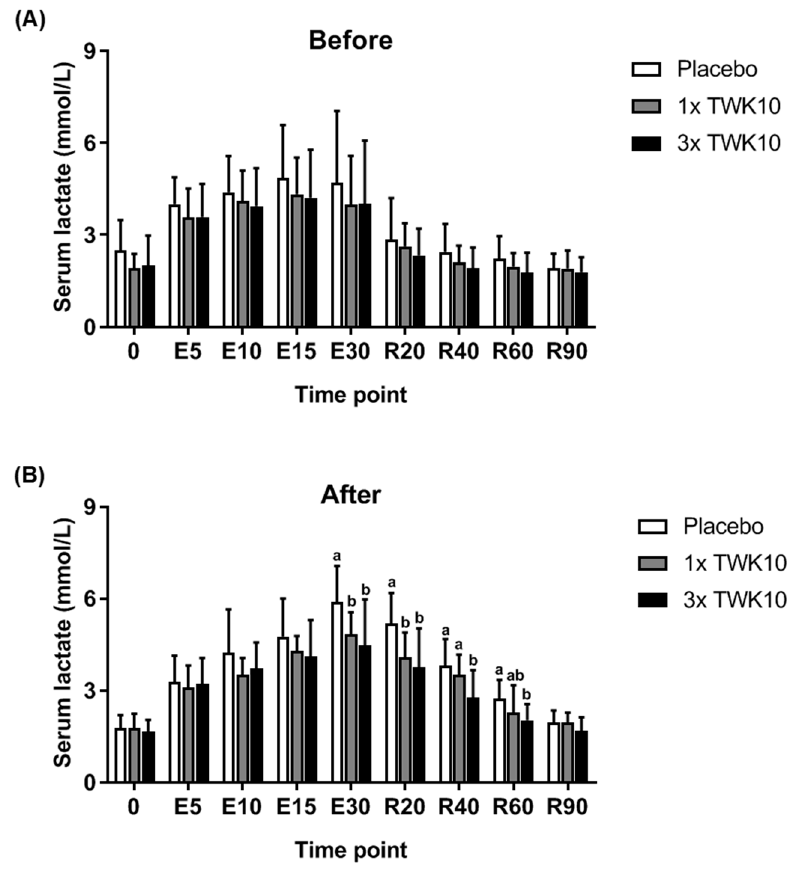
Figure 3. TWK10 reduced the content of serum lactate during and after exercise. E: Exercise; R: Rest. During fixed intensity and period exercise tests, blood samples were collected for lactate measurements at indicated time points. The contents of serum lactate were assessed ( A ) before and ( B ) after TWK10 administration. Data are shown as the mean ± SD. Statistical differences among groups were analyzed using the Tukey–Kramer test, and different letters (a, b) indicate a significant difference at P < 0.05.